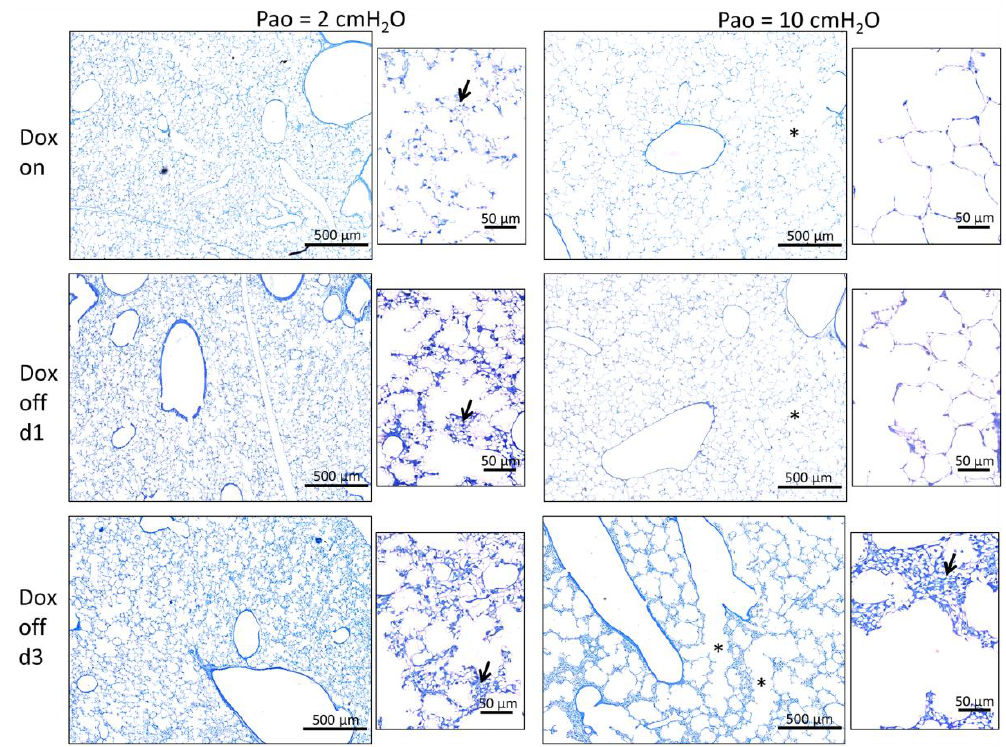
Figure 2. Microatelectases. Representative light microscopic images of Dox on, Dox off d1 and Dox off d3 of lung tissue fixed at end-expiratory airway opening pressure (Pao) of 2 and 10 cmH 2 O. The arrows indicate piled septal walls due to microatelectases which can be observed at Pao = 2 cmH 2 O in all study groups, while at Pao = 10 cmH 2 O microatelectases are present in Dox off d3 but not Dox on or Dox off d1. In addition, the alveolar ducts appear enlarged in some regions (asterisk) in Dox off d3 at Pao = 10 cmH 2 O. Arrow: microatelectasis; asterisk: alveolar duct.